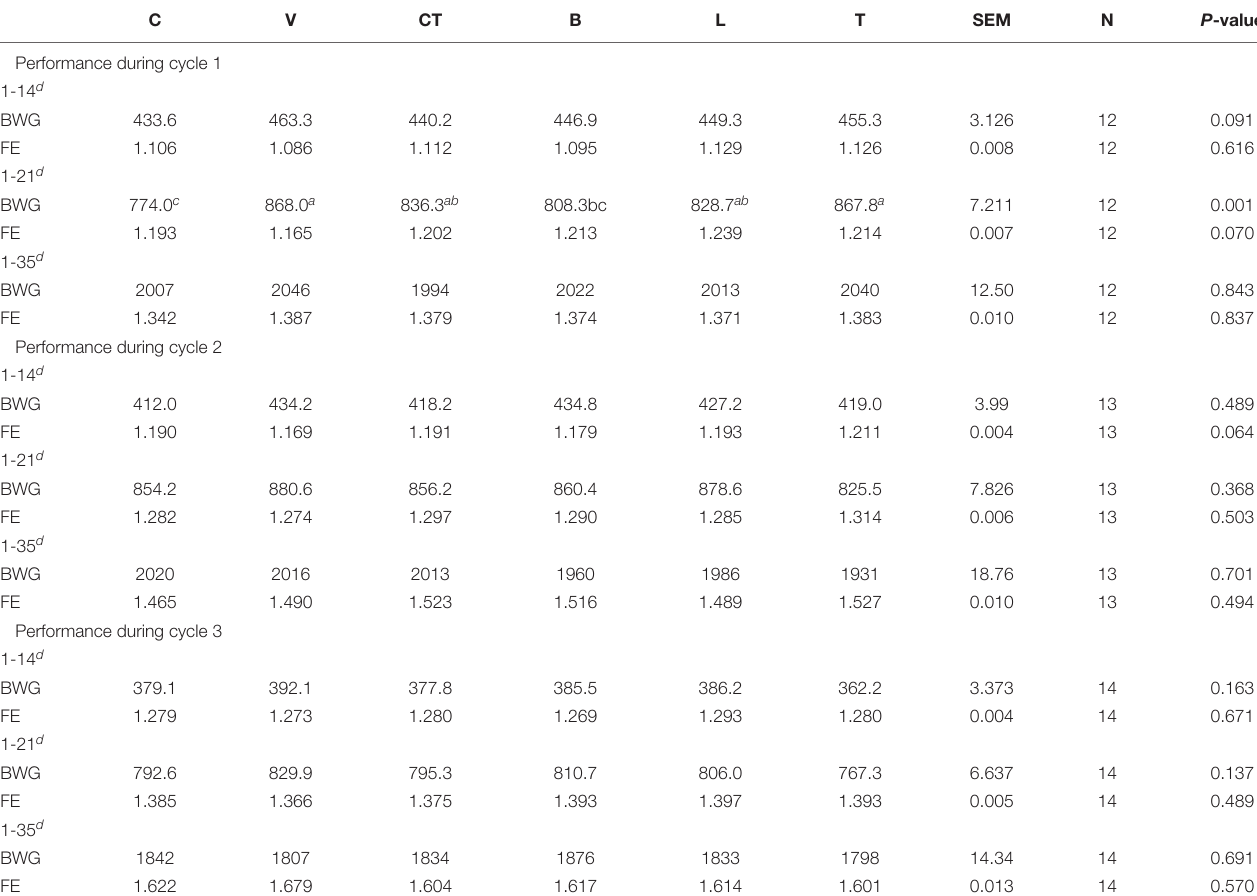
TABLE 1 | Effect of supplementing different antibiotic growth promoters on the performance of broiler chicken during three consecutive production